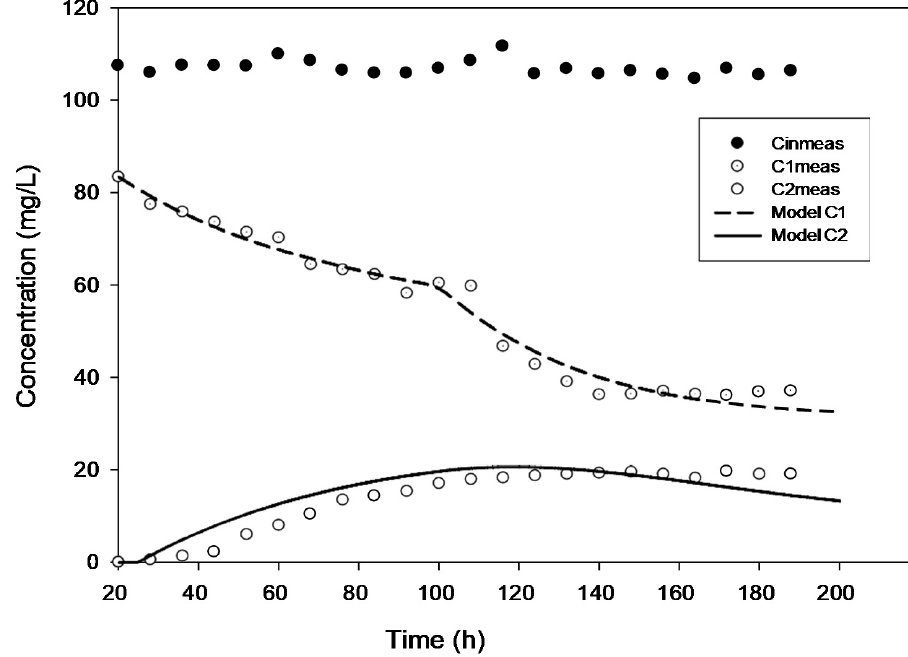
Figure 1. Model validation for the concentration of 50 mg·L − 1 .